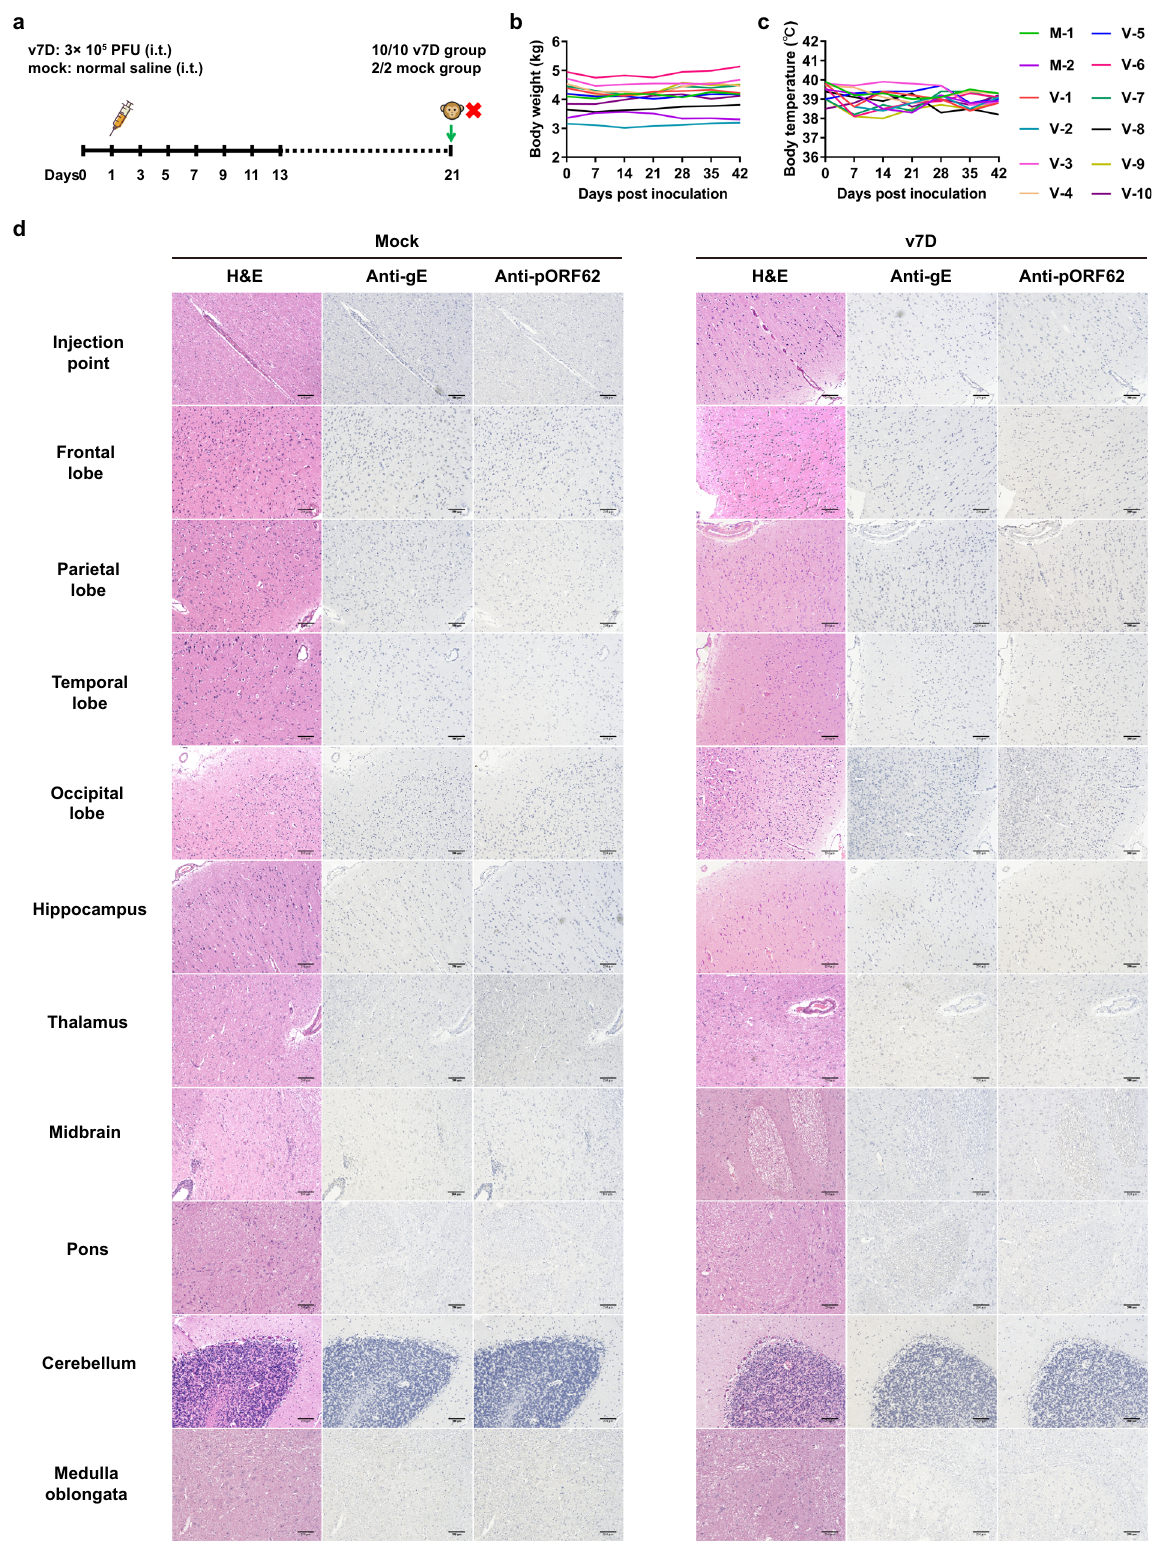
Fig. 6 v7D lacks neurovirulence in nonhuman primates. a Timeline of the experimental setup for the intrathalamical acute toxicity study in rhesus macaques. Ten animals were inoculated once intrathalamically (i.t.) with 3 × 10 5 PFU of v7D, and two animals received an equal volume of normal saline as the mock control. At 21 dpi, animals were sacri fi ced for histopathologic examination. b , c Body weights and body temperature of the animals were monitored throughout the study. M the mock group, V the v7D group. d Representative histopathological images of different regions of the rhesus macaque brain following intrathalamical administration of v7D at 21 dpi. The experiment was repeated twice with similar results. Scale bars indicate 200 μ m. Source data are provided as a Source Data fi